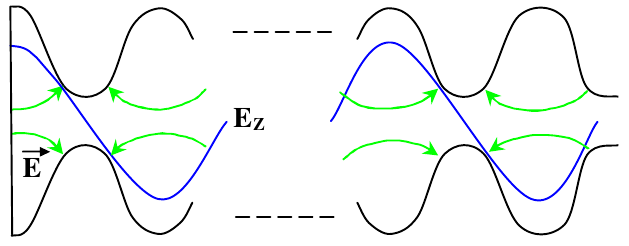
FIG. 2. (Color) A multicell rf gun. The green lines are the electric field lines, and the blue line is the field’s strength on the axis.